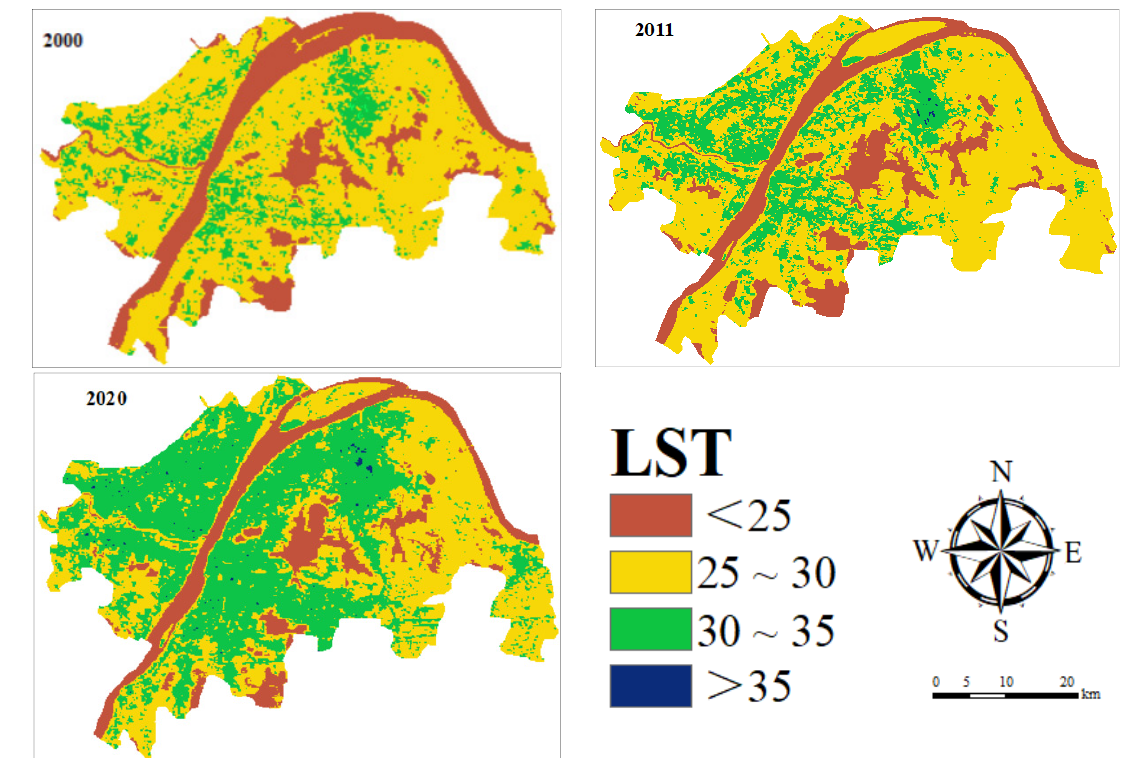
Figure 4. LST variation in the study area.